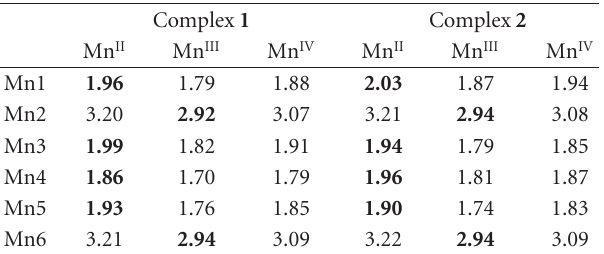
Table 4: Bond valence sum (BVS) a,b calculations for complexes ( 1 · 2.5H 2 O) ∞ and ( 2 · 2MeCN)